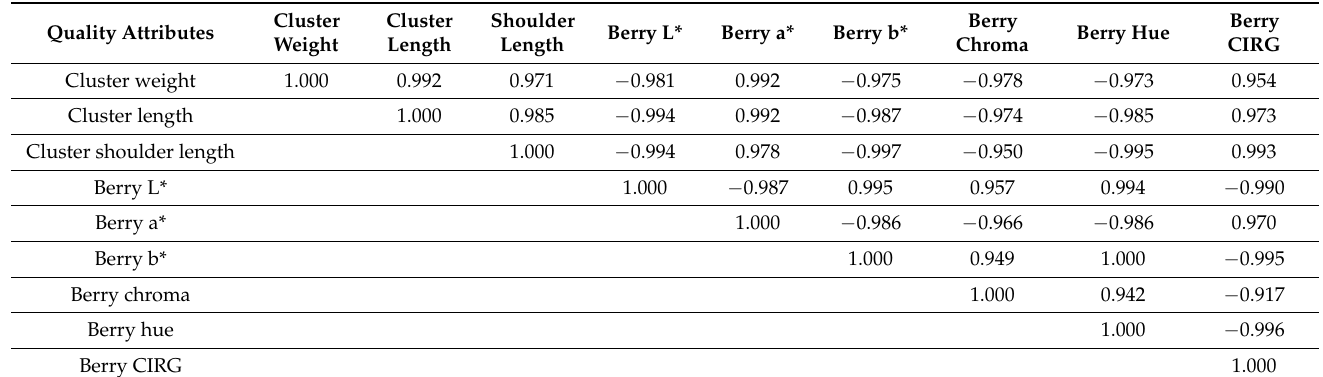
Table 7. Pearson’s correlation coefficients ( r ) describing the correlations among quality attributes of Flame Seedless grape cultivated by different agricultural practices.